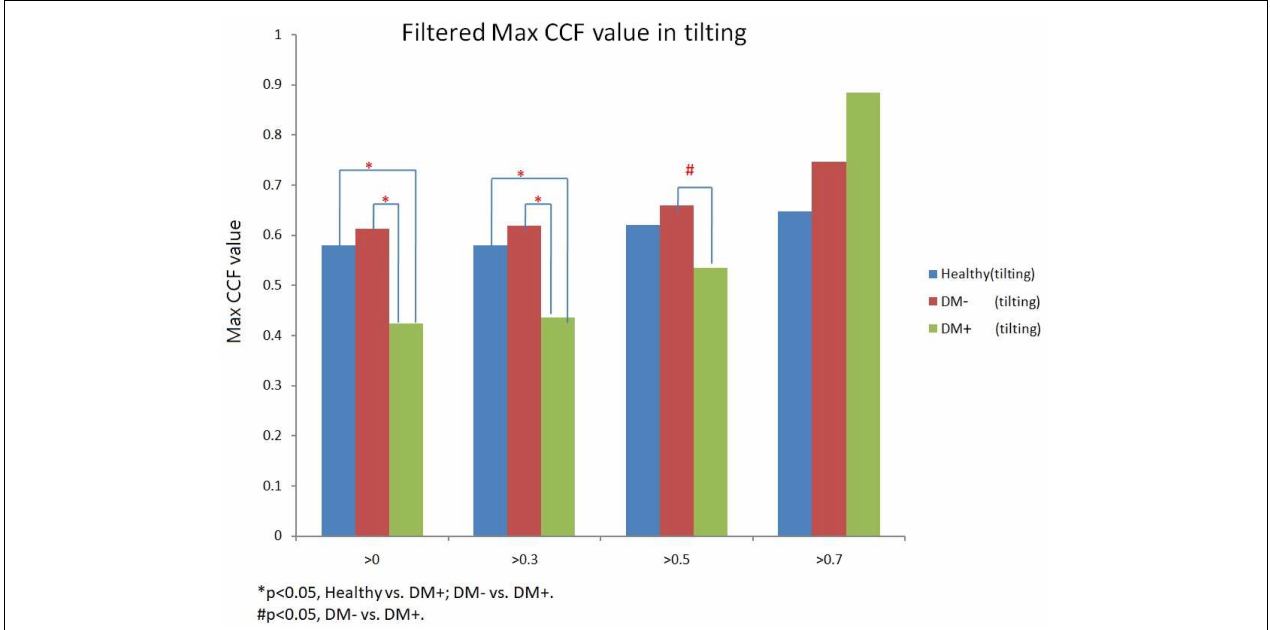
FIGURE 12 | The filtered maximum CCF value in healthy (blue), diabetes mellitus (DM–, red), and DM with autonomic neuropathy (DM+, green) using the threshold CCF > 0, 0.3, 0.5, and 0.7 during tilting position. The symbol “*” and “#” mean the p -value smaller than 0.05 in t